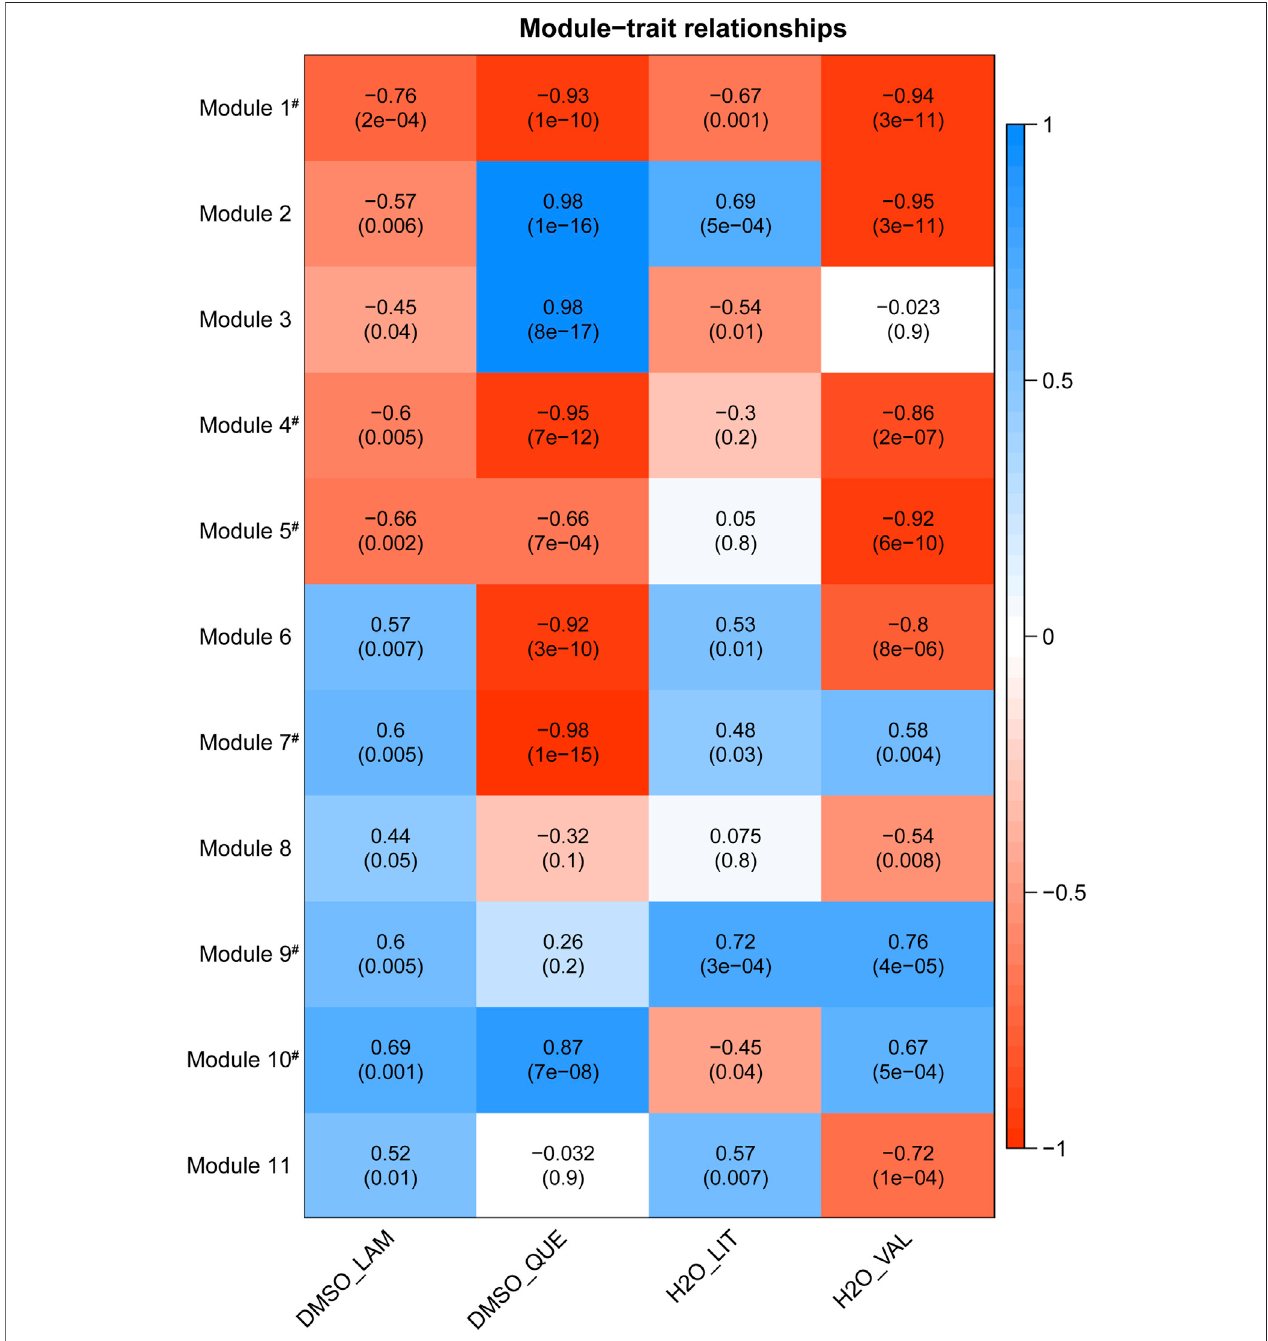
FIGURE 2 | Heatmap of module-trait relationships with corresponding p -values between the detected modules on the y -axis and vehicle-drug traits on the x -axis. The correlation value and Benjamini – Hochberg adjusted p -value for each pair are labelled on the cell in the format: correlation ( p -value). Each cell of the heatmap is colouredbasedoncorrelationbetweeneachmoduleeigenvalueandthetrait:blueisastrongpositivecorrelation,redisastrongnegativecorrelation,andwhiteislittleto no correlation. For example, regarding the DMSO-Lamotrigine trait, the module 5, with the negative correlation value of − 0.66 and signi fi cant adjusted p -value of 0.002, tends to have lower overall expression (summarised as eigengene value) in lamotrigine treatment compared with the corresponding DMSO vehicle control. Abbreviation: DMSO_LAM – Lamotrigine treatment versus DMSO vehicle, DMSO_QUE – Quetiapine treatment versus DMSO vehicle, H2O_LIT – Lithium treatment versus water vehicle, H2O_VAL – Valproate treatment versus water vehicle. Modules labelled with hash (#) were coherently regulated with same directionality by at least three drugs. LncRNA-mRNA co-expression networks, identi fi cation of hub lncRNAs.